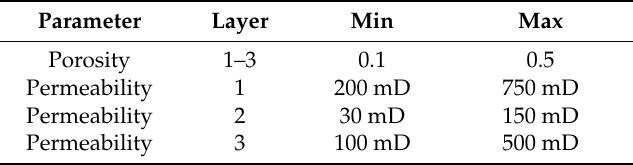
Table 1. The statistical features of uncertain